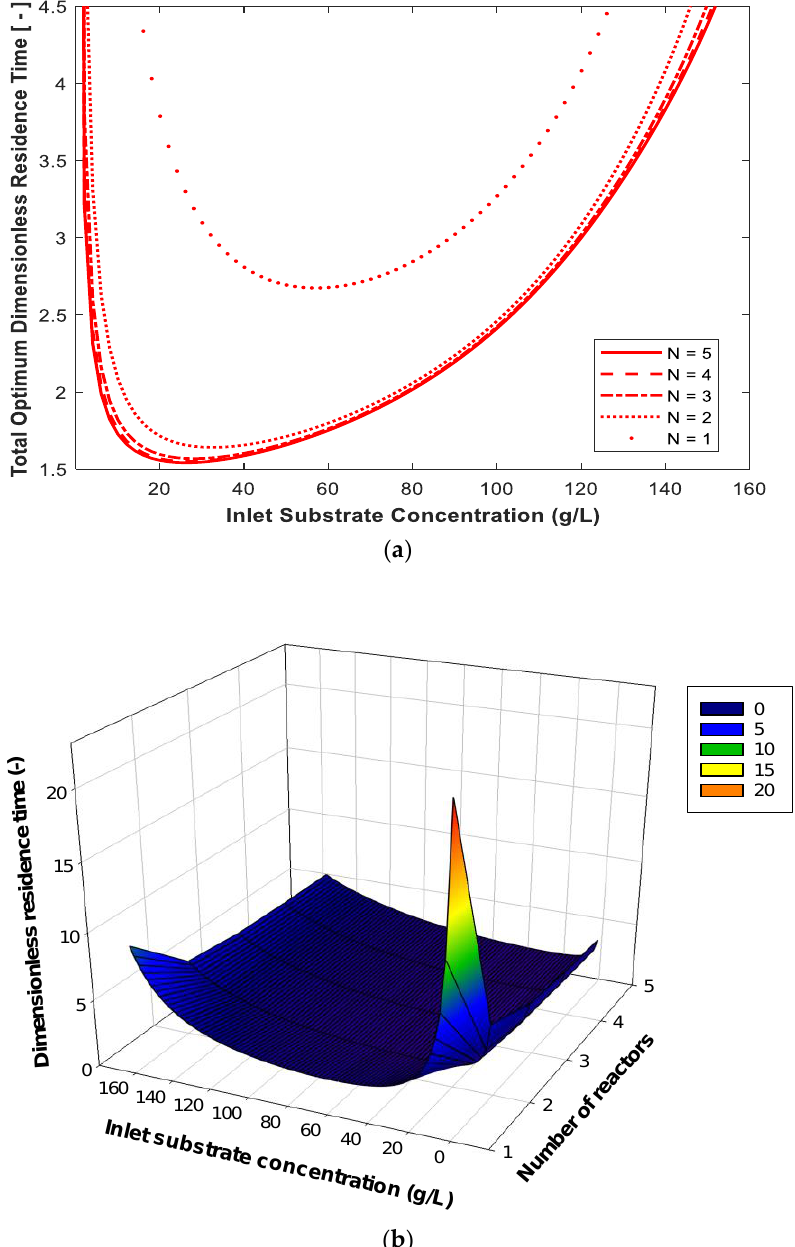
Figure 4. ( a ) Effect of substrate concentration in the feed to the first reactor using different reactor stages on the total optimum dimensionless residence time; ( b ) the same relation shown in a 3D surface plot. Substrate conversion: 99%. X o = 0.01 g/L. P o = 0.